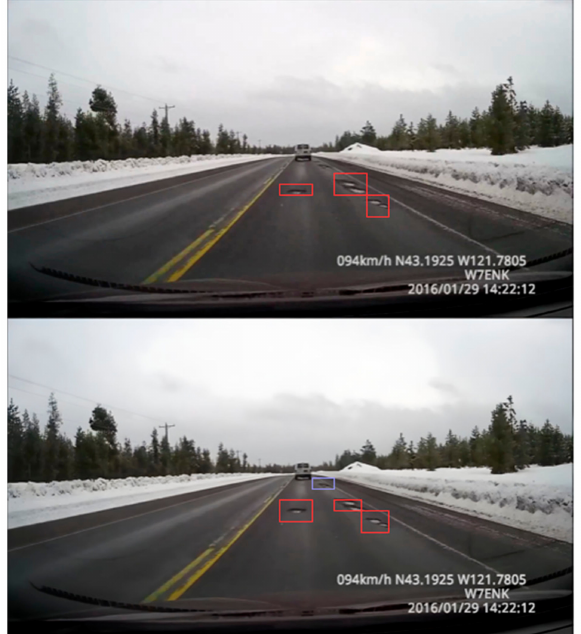
Figure 2. The first image shows detected instances on an LR image, and the second image shows detection on an SR image, which detected more instances of potholes, particularly an instance at a